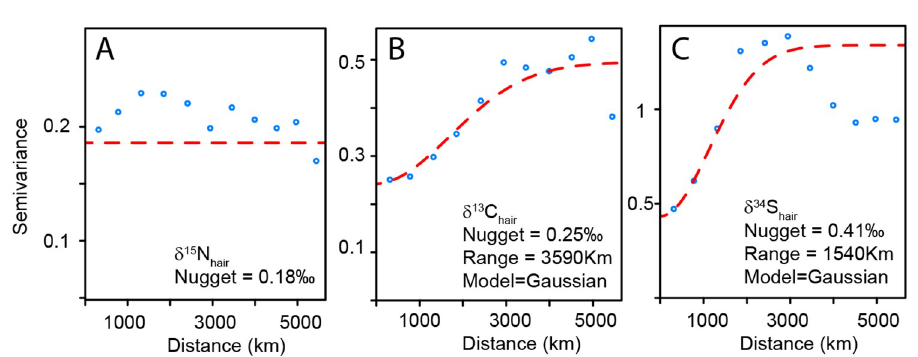
Fig 4. Semivariograms. A. δ 15 N hair variations; B. δ 13 C hair variations; C. δ 34 S hair variations. The x-axis distance represents the distance between pairs of observations. The blue points represents the average value of semivariance between point pairs for each 500km distance bin. The red lines represent theoretical semivariograms. Note the nugget value is approximately equal to the analytical precision of 0.2‰, 0.2‰, and 0.4‰ for δ 15 N hair , δ 13 C hair , and δ 34 S hair values, respectively.